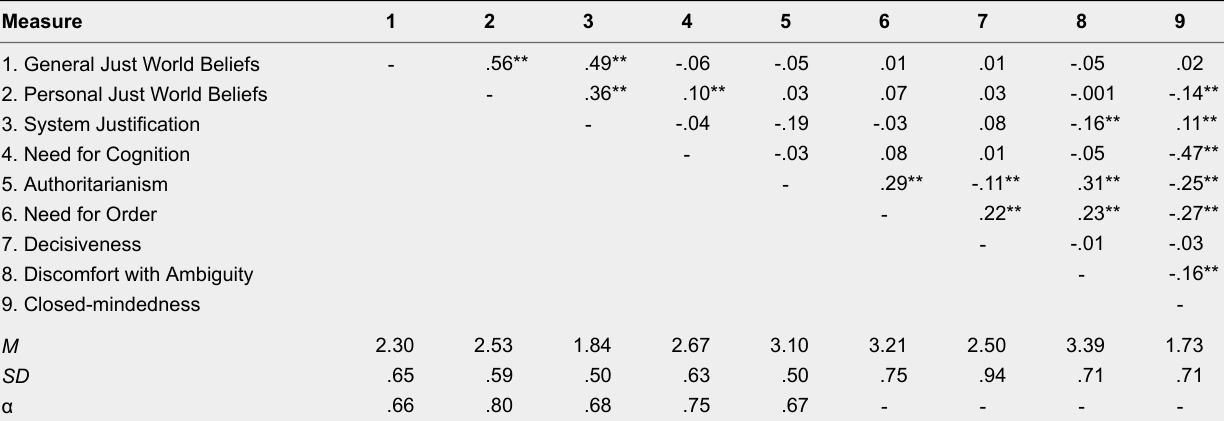
Descriptive statistics and correlations between measures (N =